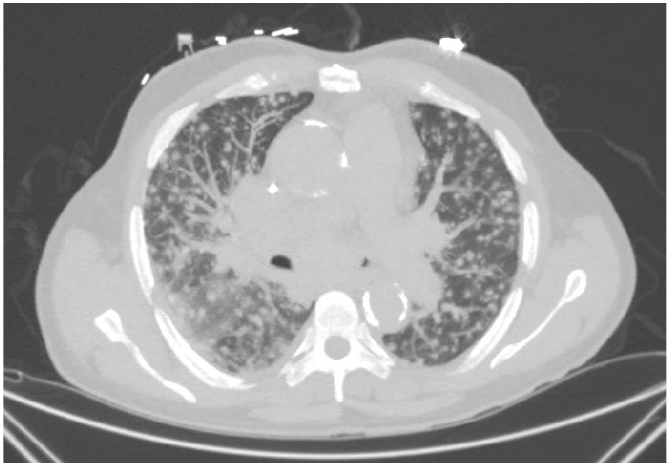
Figure 8. Progressive disseminated histoplasmosis. CT chest showing diffuse reticulonodular infiltrates with large mediastinal lymphadenopathies.